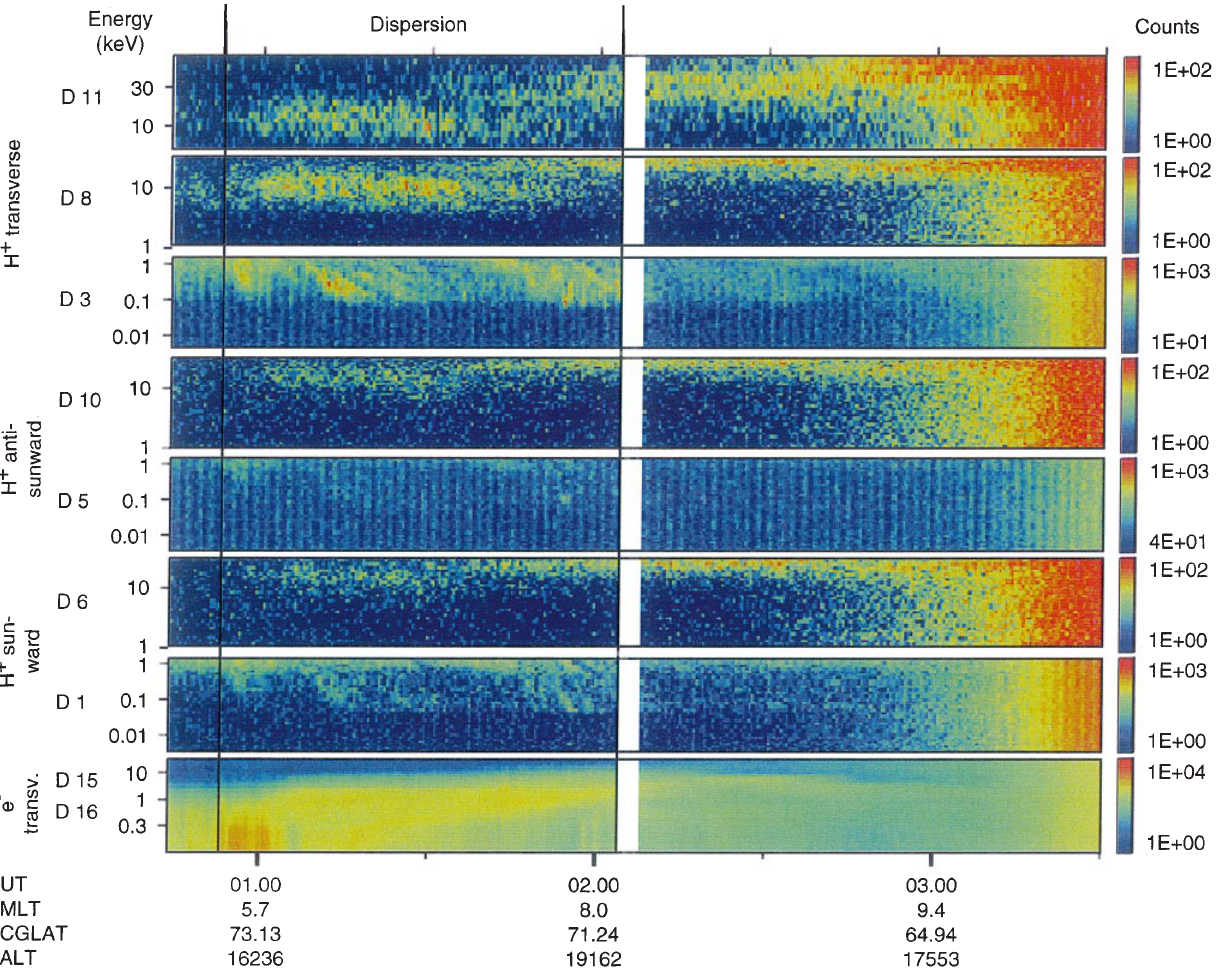
Fig. 14. Spectrogram from Interball-2 showing the period between 0040 and 0330 UT on October 4, 1996. Dispersion structures were detected between 0053 and